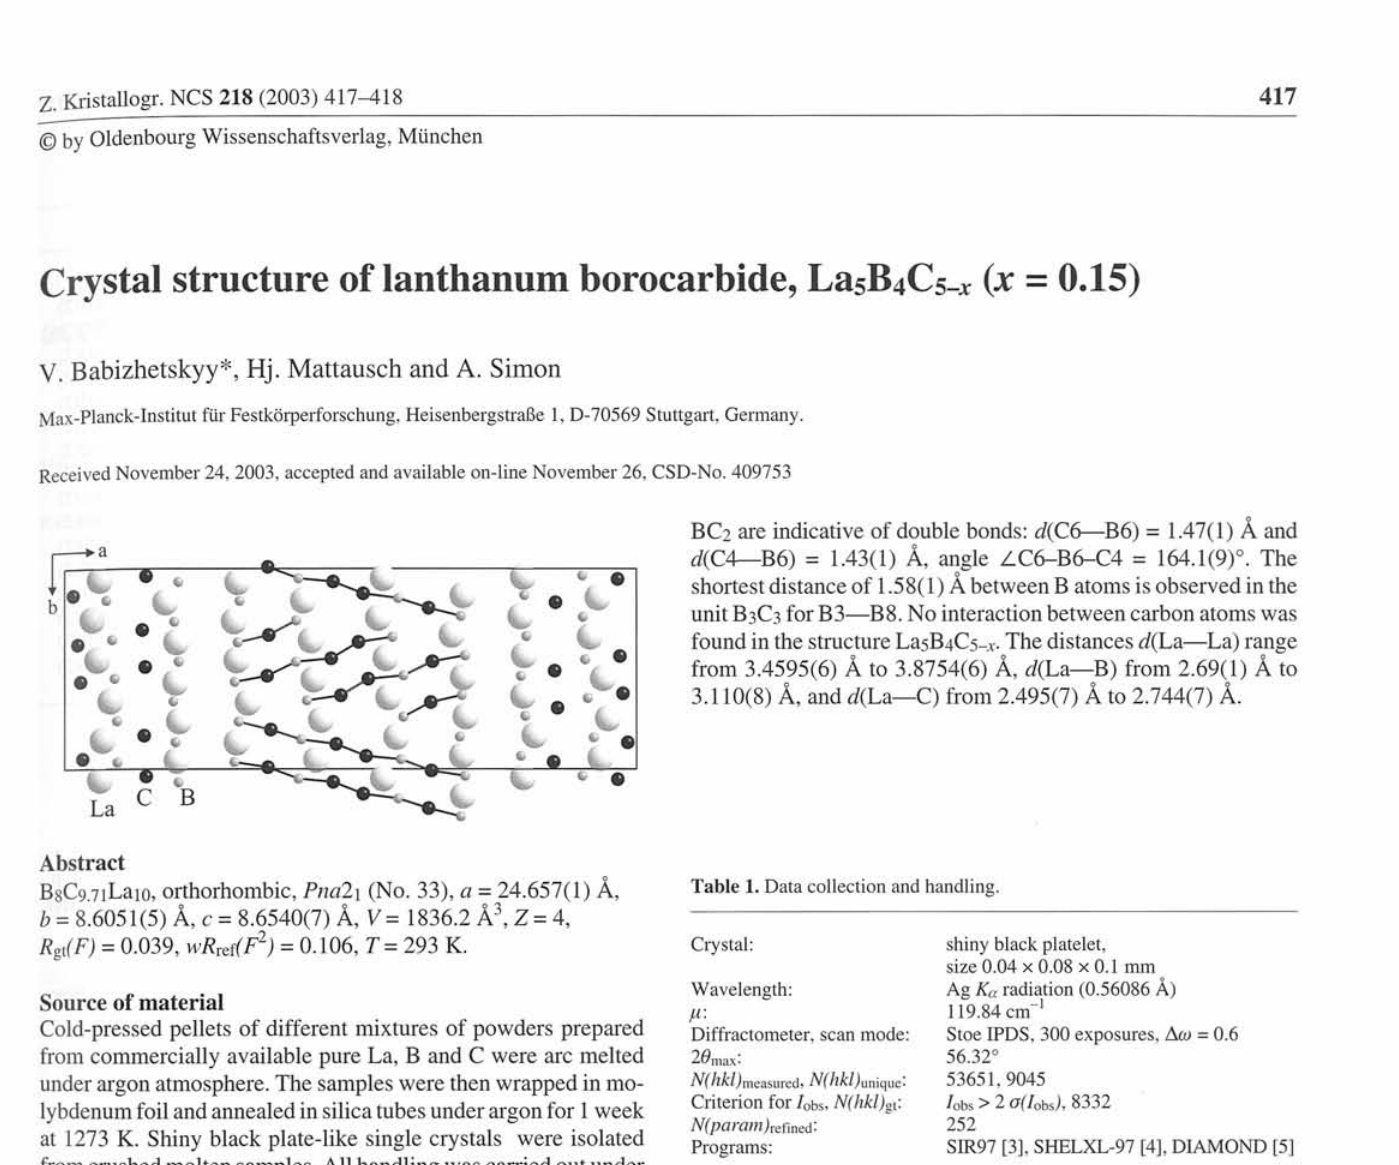
Table 2. Atomic coordinates and displacement parameters (in A").